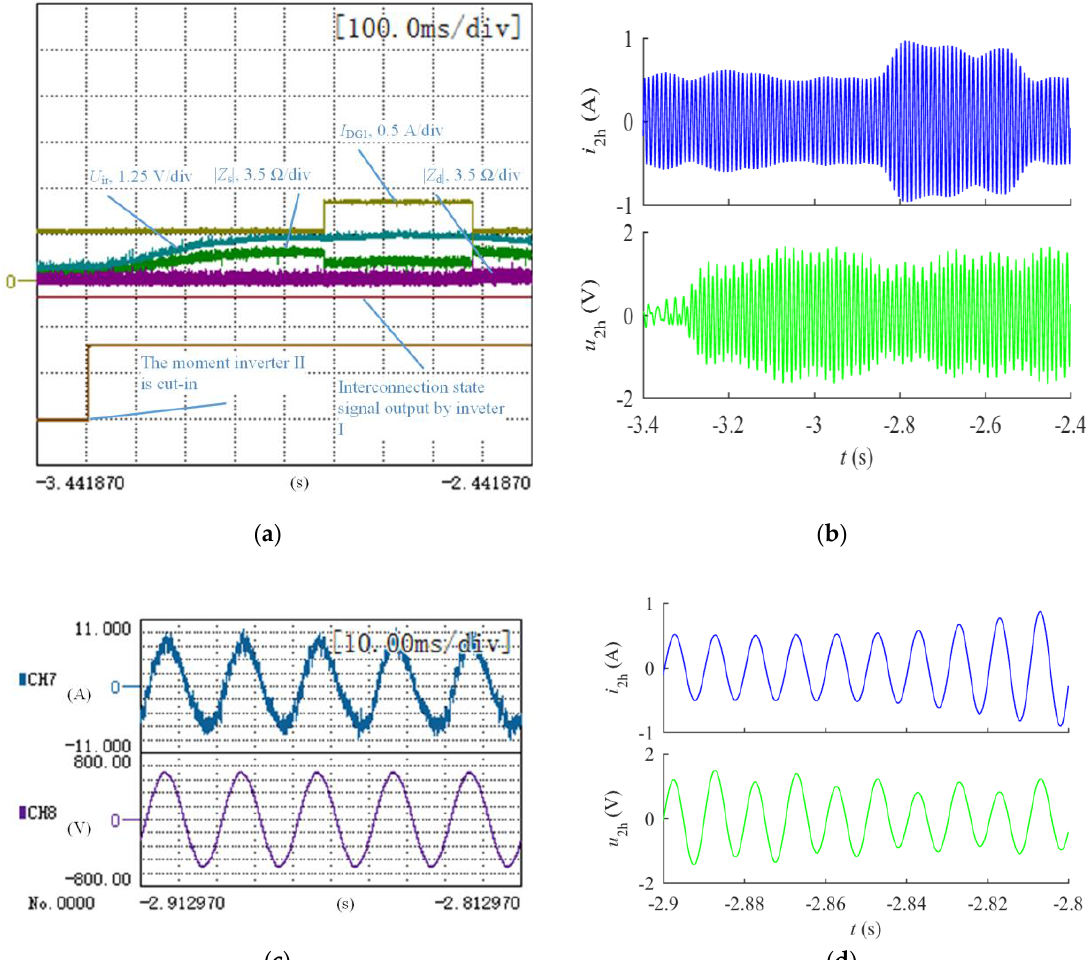
Figure 11. DG unit cut-in event occurring and the related waveforms of current and voltage. ( a ) The whole process before and after the event; ( b ) Waveforms of the second harmonic current and voltage during the whole process; ( c ) Measured current and voltage before and after the change of I DG1 ; ( d ) Waveforms of the second harmonic current and voltage contained in the measured current and voltage shown in ( c ).